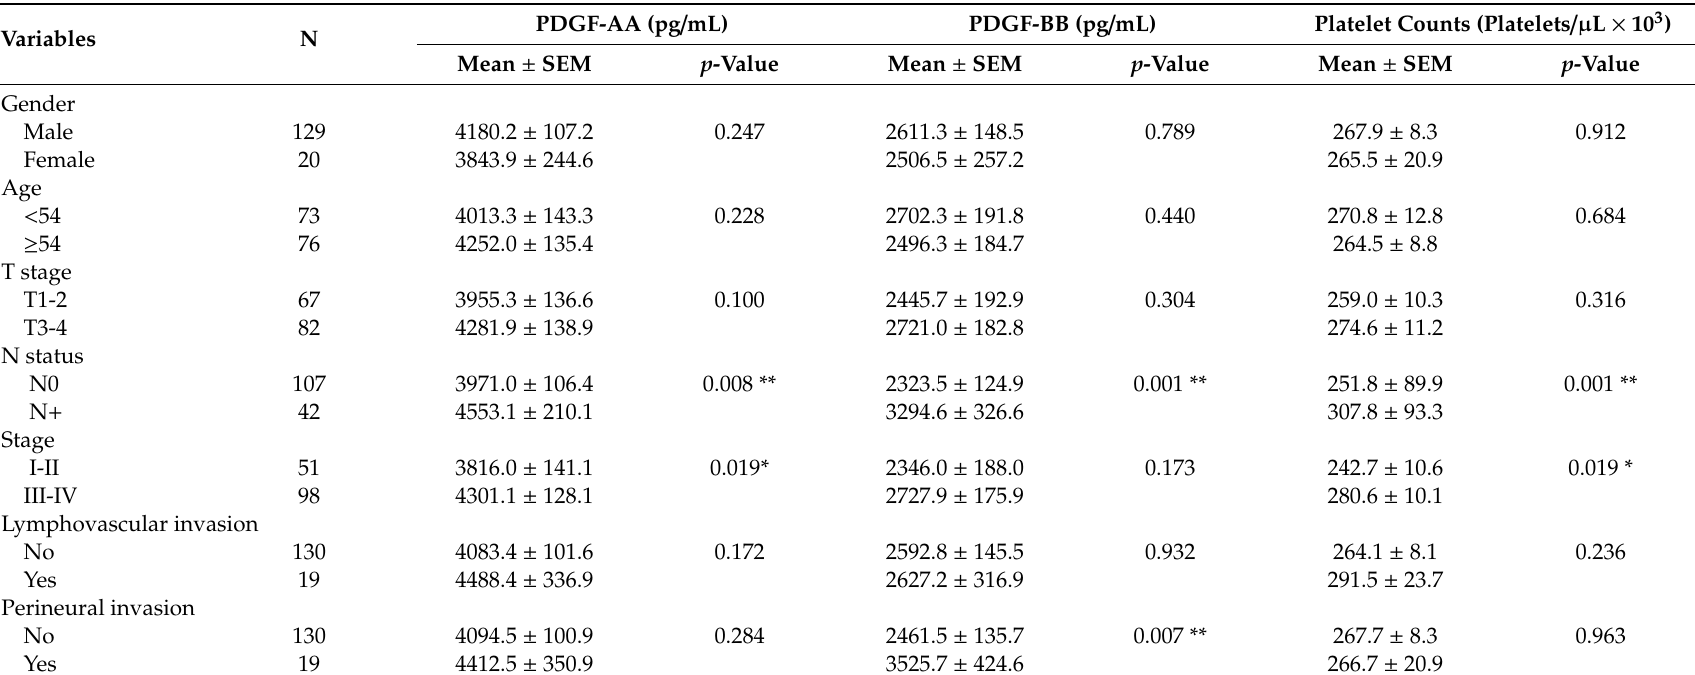
Table 3. Relationship between clinical parameters and preoperative serum PDGF-AA, PDGF-BB, and platelet count in OSCC